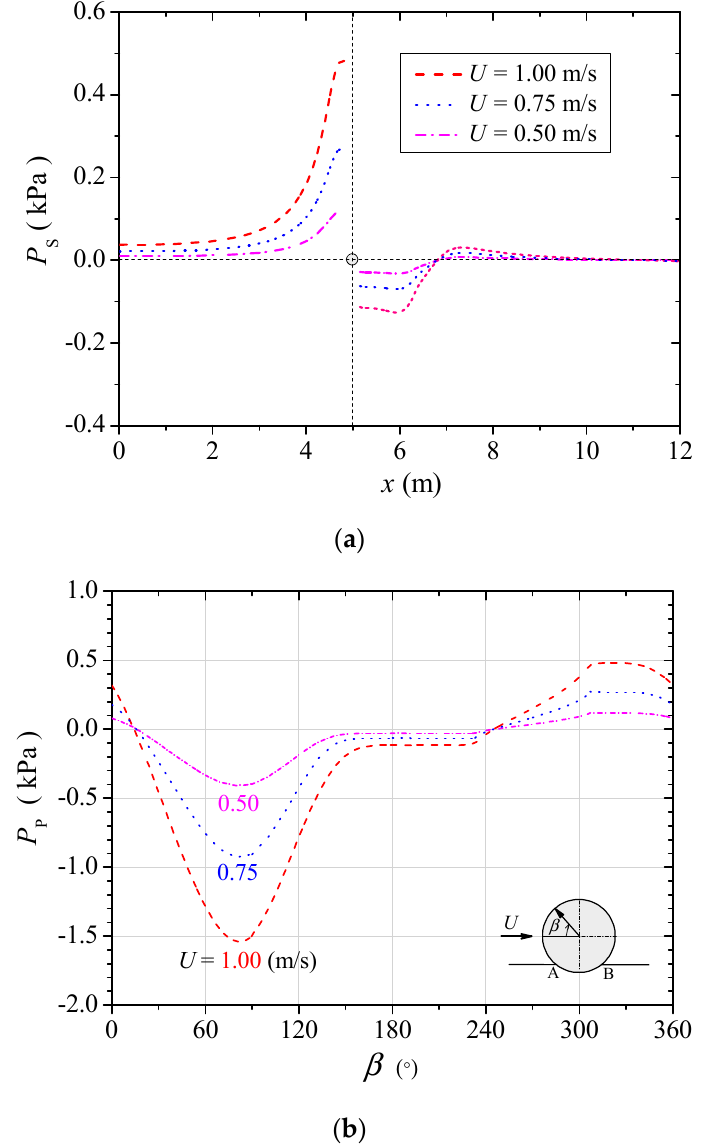
Figure 7. Pressure distributions for various inflow velocities ( a ) along the mudline around the pipe (the pipe is located at x = 5.0 m) and ( b ) along the pipe surface.